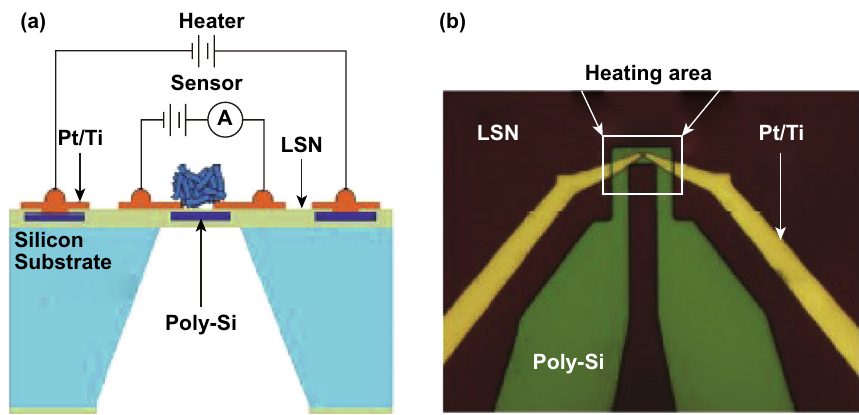
Fig. 19 a Schematic diagram of NO 2 gas sensor with microheater sensor. b Optical image of poly-silicon microheater with Pt/Ti electrodes. Reproduced with permission from Ref. [118]. Copyright (2016)